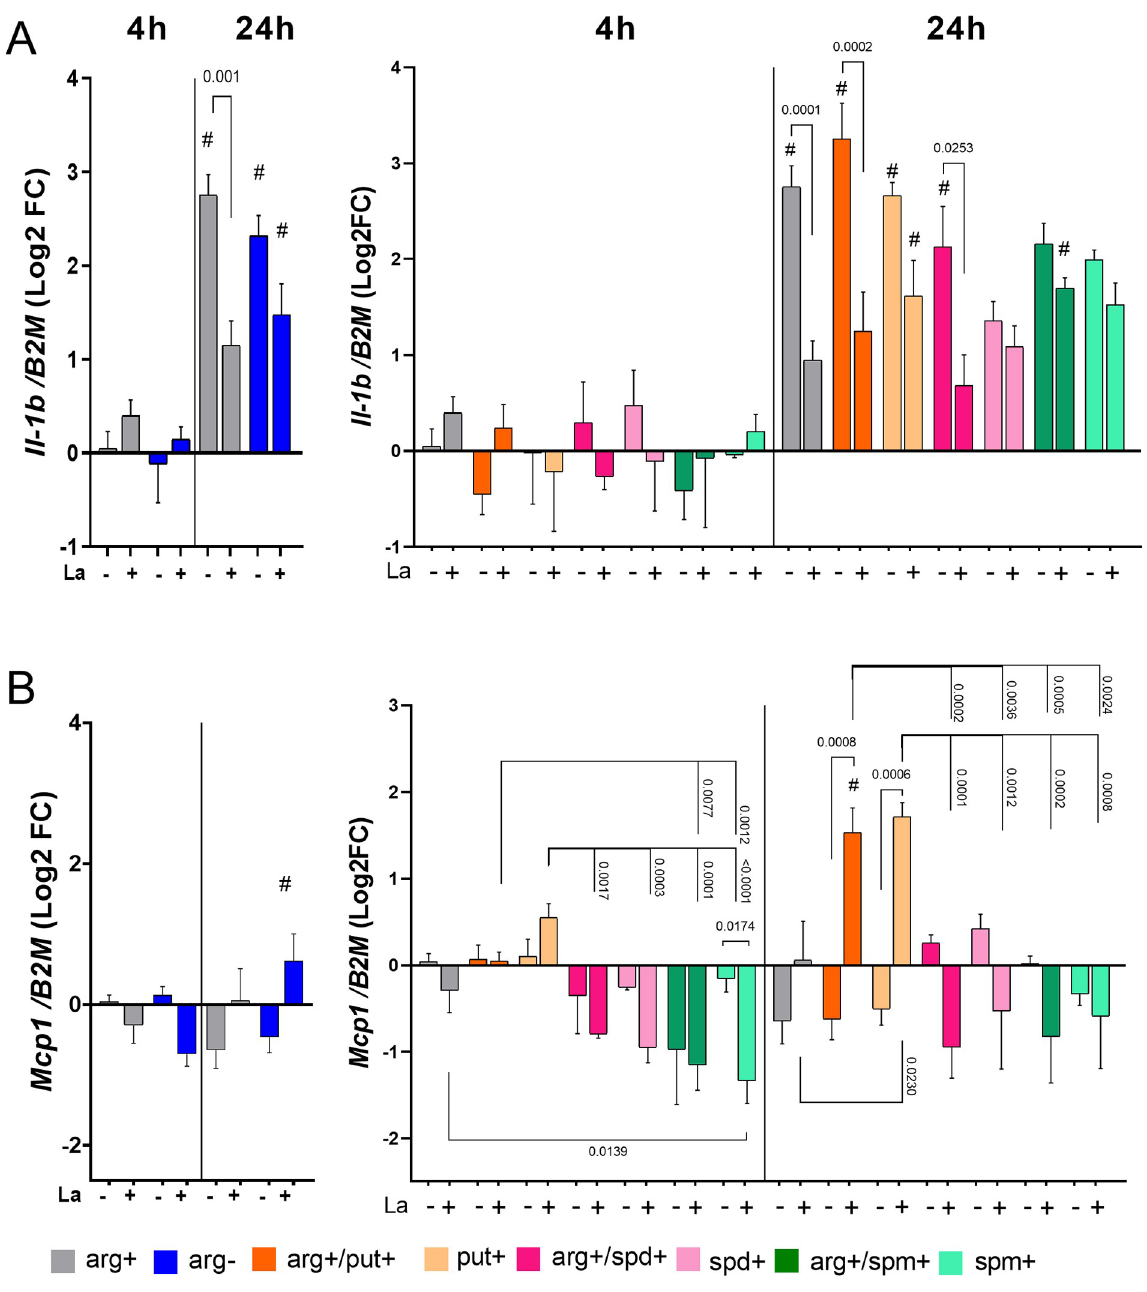
Fig 4. Relative expression of proinflammatory cytokines in BALB/c macrophages infected or not with L . amazonensis with or without polyamines supplementation. Macrophages were supplemented with putrescine (put+), spermidine (spd+), spermine (spm+) with or without L-arginine (arg+) concomitant or not to L . amazonensis infection (MOI 5:1) for 4h, and after 24h in complete medium. RNA was extracted for cDNA conversion and relative quantification of genes Il-1b (A) and Mcp1 (B) by RT-qPCR. Data were normalized using the β -2-microglobulin gene, and uninfected macrophage arg+ at 4 h was used as a reference for ΔΔ CT relative quantification. The bars represent the averages and S.E. M. We performed three independent experiments. Statistical analysis using One-Way ANOVA with mixed-effects, post-hoc test Sidak’s multiple comparisons. # : p � 0.05 for the comparison between 4h vs. 24h.